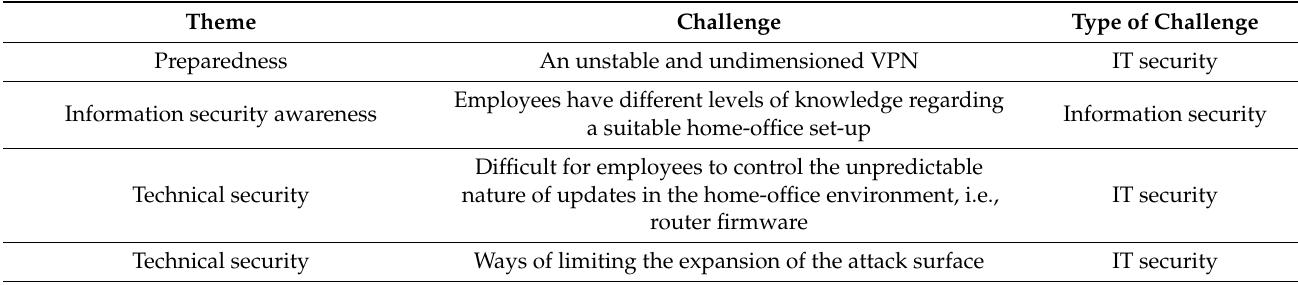
Table 1. Summary of the challenges experienced by Alpha during the teleworking period of the COVID-19 pandemic.